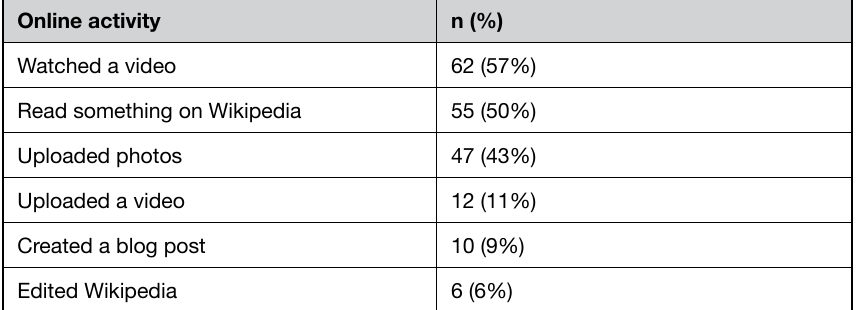
Table 2: Participants’ engagement with common online activities (N=109) Online activity